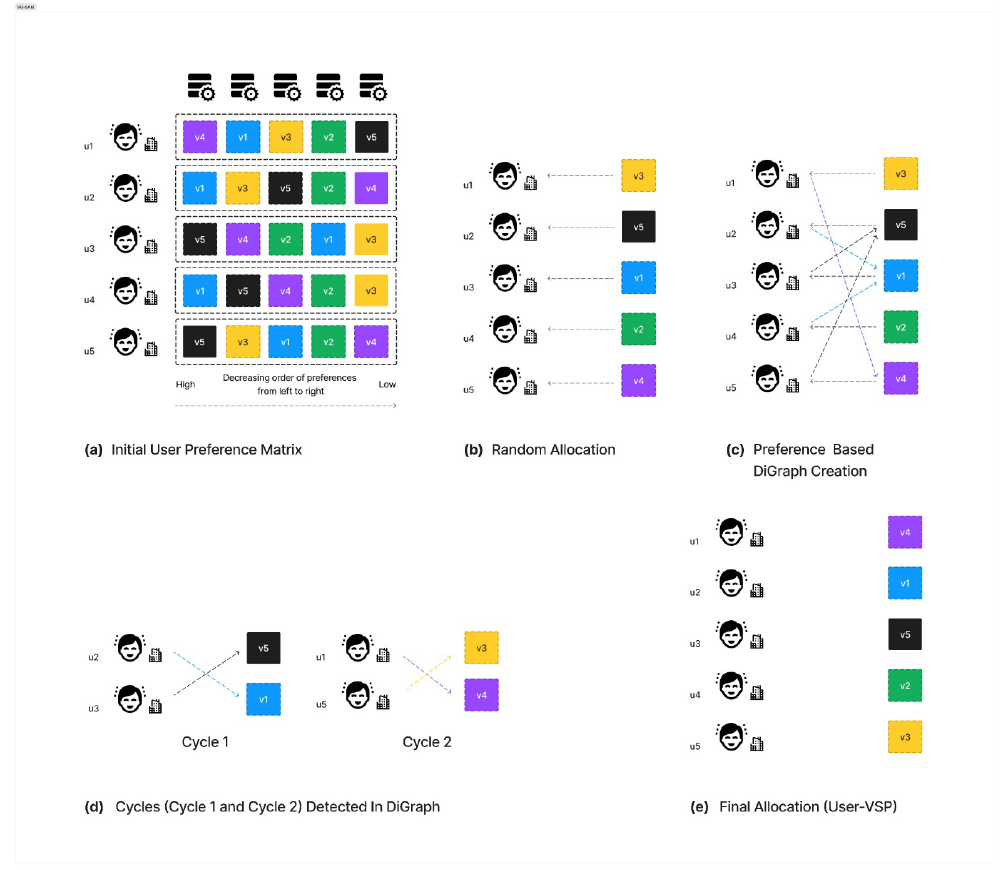
Figure 5. The detailed functioning of the VU-SAM algorithm (Algorithm 2) where the number of users is equal to the number of VSPs ( n =